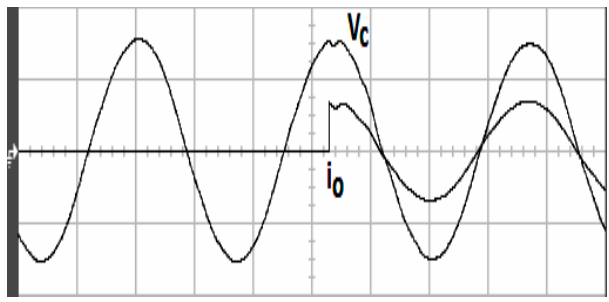
Figure 7. Experimental waveforms under step loading from no load to full load with the improved technique (100 V/div; 20 A/div; 5 ms/div).